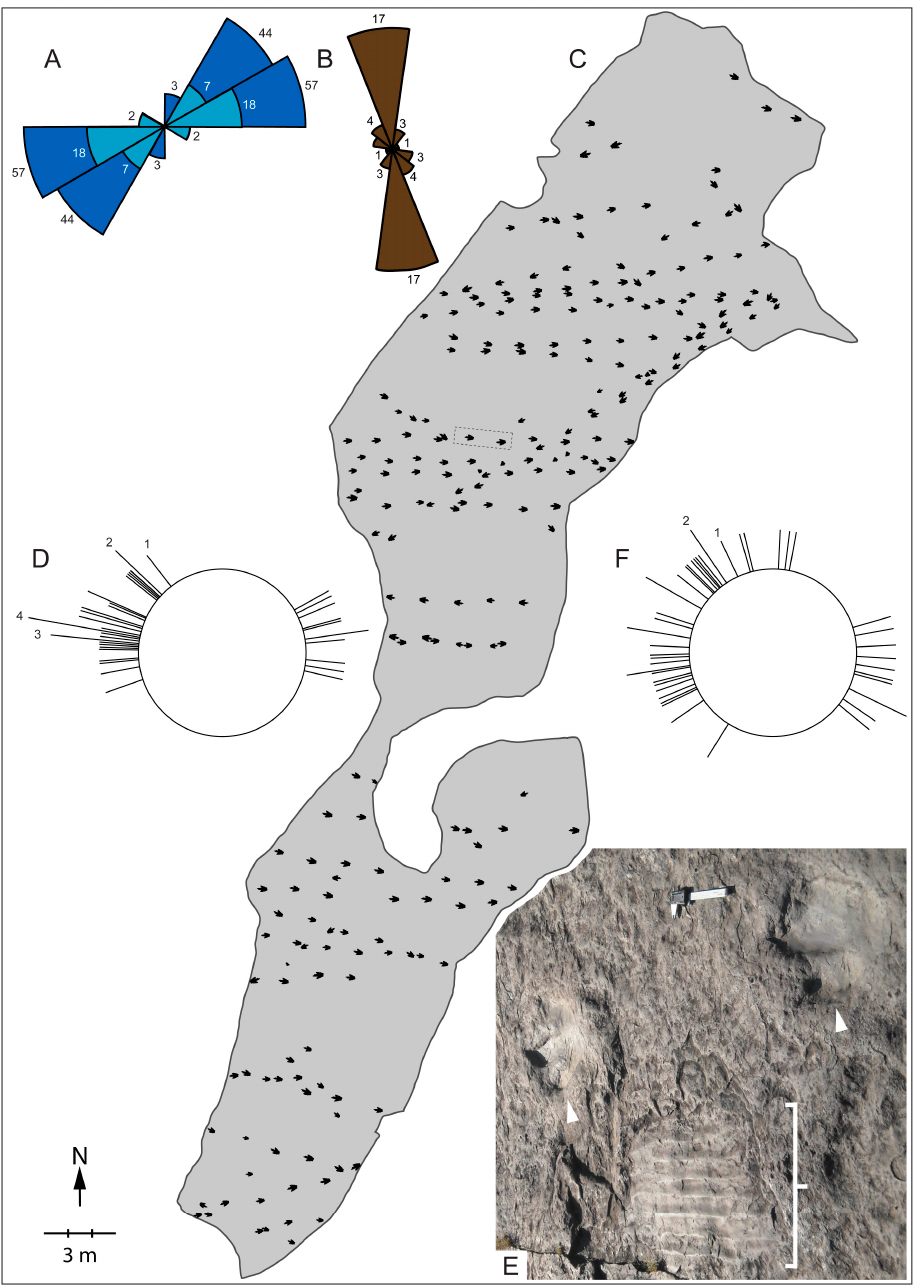
Figure 2. Sedimentary structures, trackways, and orientations from Dinosaur Footprint Reservation, in Holyoke, Massachusetts. ( A ) Rose diagram of the orientation of oscillation ripples above (light blue) and below (dark blue) the main track bed; ( B ) Rose diagram of the long axes of fossilized logs on beds ~69 m above the main track bed; ( C ) Sketch map of the main track bed; ( D ) Rose diagram of track and trackway orientations on the main track bed; ( E ) Photograph of Eubrontes giganteus showing the trackway paralleling the ripples (bracketed) underneath the bed. Digital caliper for scale; ( F ) Rose diagram of trackway orientations on 23 different beds ~69 m above the main track bed.